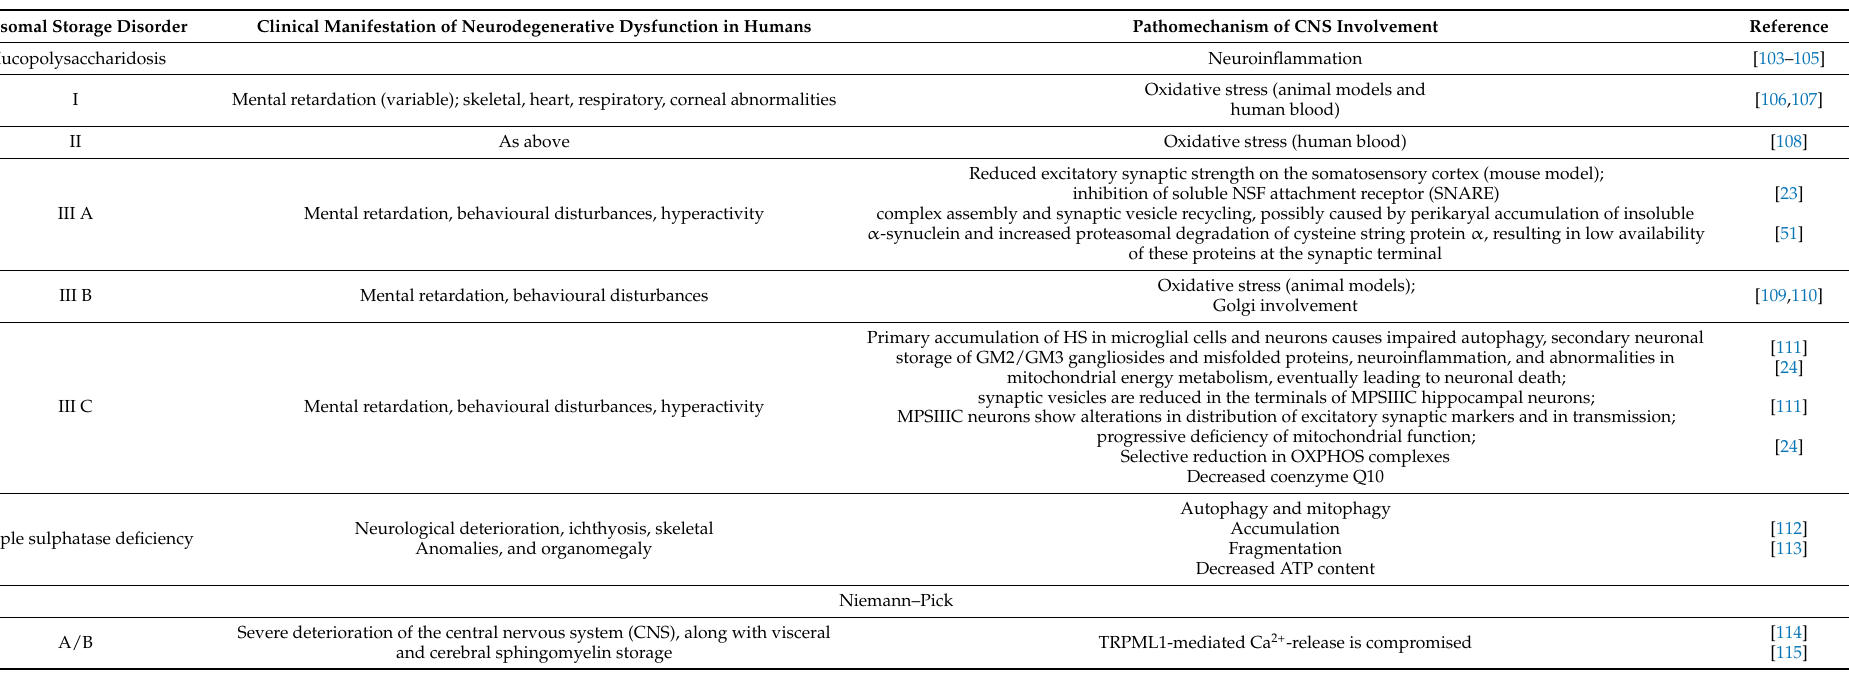
Table 1. Mechanisms of neurodegenerative dysfunction in